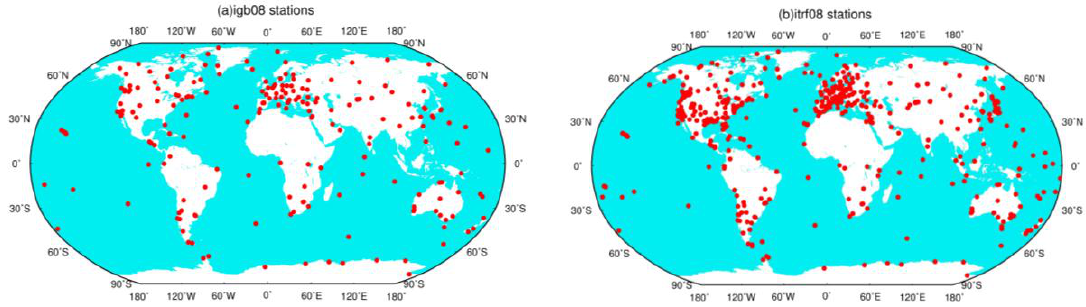
Figure 1. Two site distribution: 232 reference stations of IGb08 ( a ), and 560 reference stations of ITRF08 ( b ). Then the simulated displacements are used to invert harmonic coefficients with various truncation degrees. The truncation degrees are ranged from degree 1 to degree 10 for both ‘sta232’ and ‘sta560’, as the normal equations would be singular for a much higher truncation degree. Figure 2 shows the degree Root Mean Square (RMS) differences between the estimated coefficients from simulated GPS inversion and the reference values (mentioned in Section 2.1). Results show that the degree RMS is prone to be stable (especially for degree-1 coefficients) when we estimate coefficients up to about degree 6. The optimal truncation degrees are degree 6 for ‘sta232’ and degree 7 for ‘sta560’, respectively. Comparisons between ‘sta232’ and ‘sta560’ indicate that higher degrees can be resolved and higher-quality estimates can therefore be derived with denser site distribution.